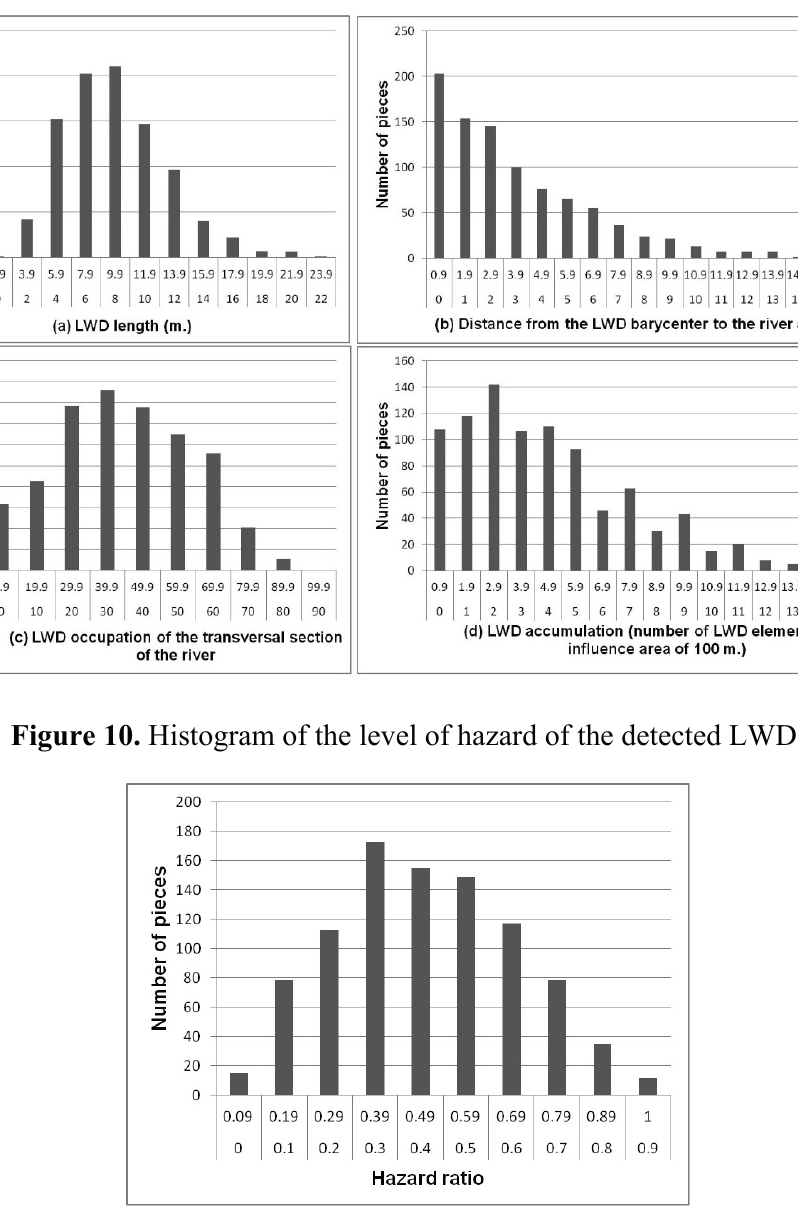
Figure 9. Histograms of the four parameters that determine the level of risk of the LWD.